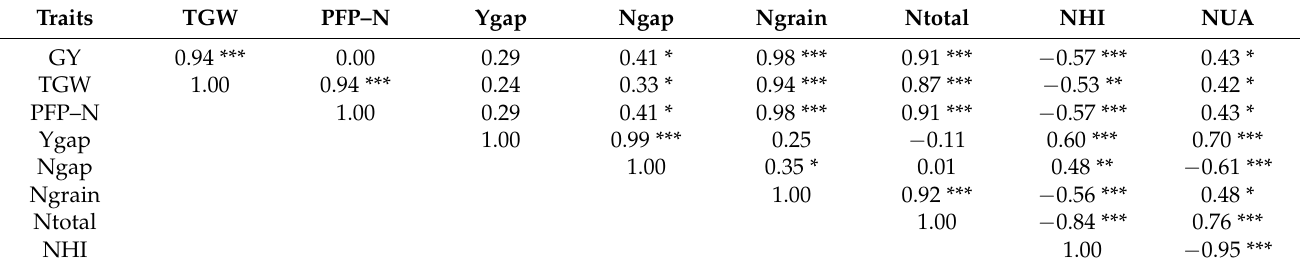
Table A3. Correlation matrix of nitrogen economy indices in winter wheat and grain yield, n = 36.